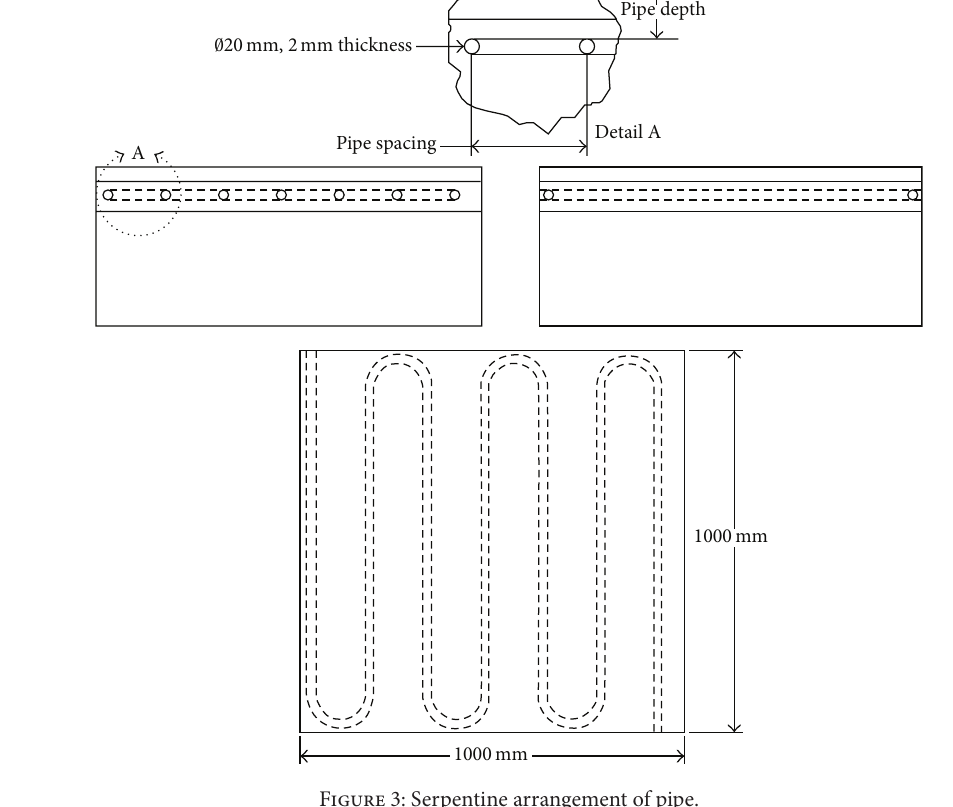
Figure 3: Serpentine arrangement of pipe.